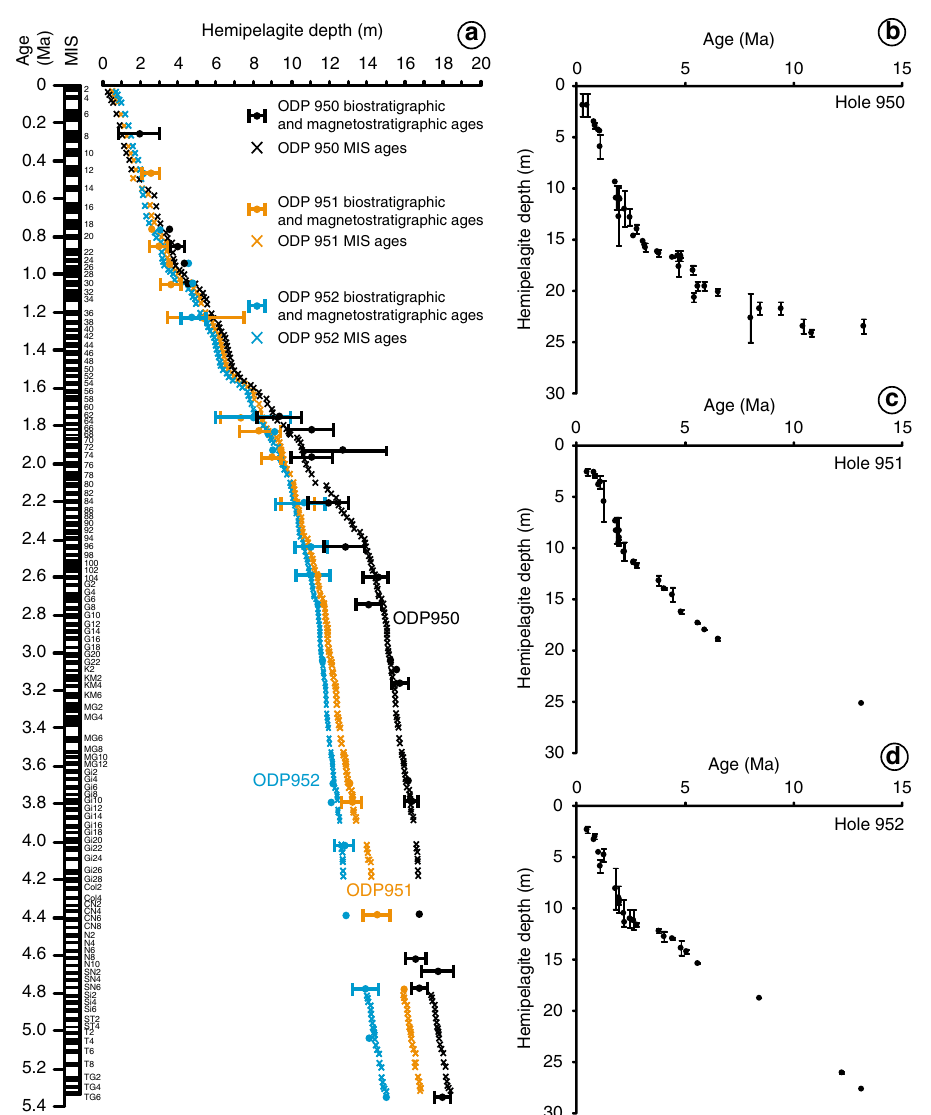
Fig. 5 Age model for Madeira Abyssal Plain sediments. Hemipelagite depth against time a for the last 5.4 million years at ODP Sites 950 (black), 951 (orange) and 952 (blue) showing hemipelagites depths of coccolith fi rst and last occurrences with error bars (circles) 38 combined with depth and age of identi fi ed Marine Isotope Stage boundaries. Lithostratigraphy of the hemipelagite records periods of sea level change, manifested in the Marine Isotope Stage record 9,37,49,63,67 . At high sea-level there is greater calcium carbonate preservation forming white calcareous oozes younger than 2.5 Ma or pale brown to light grey hemipelagites in the older record. In contrast, dark brown clays are deposited during lowstands younger than 2.5 Ma and dark grey clays in the older record 9 . Also shown are the biostratigraphic age controls up to 15 Ma for b ODP Site 950, c ODP Site 951, and d ODP Site